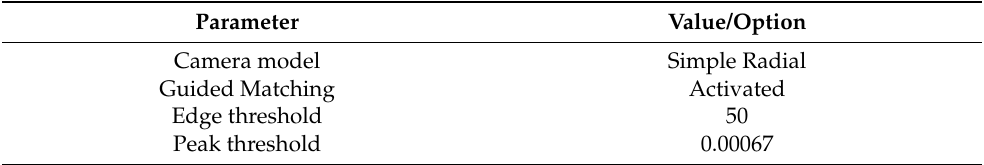
Table 5. COLMAP parameters for feature detection, matching, and point cloud